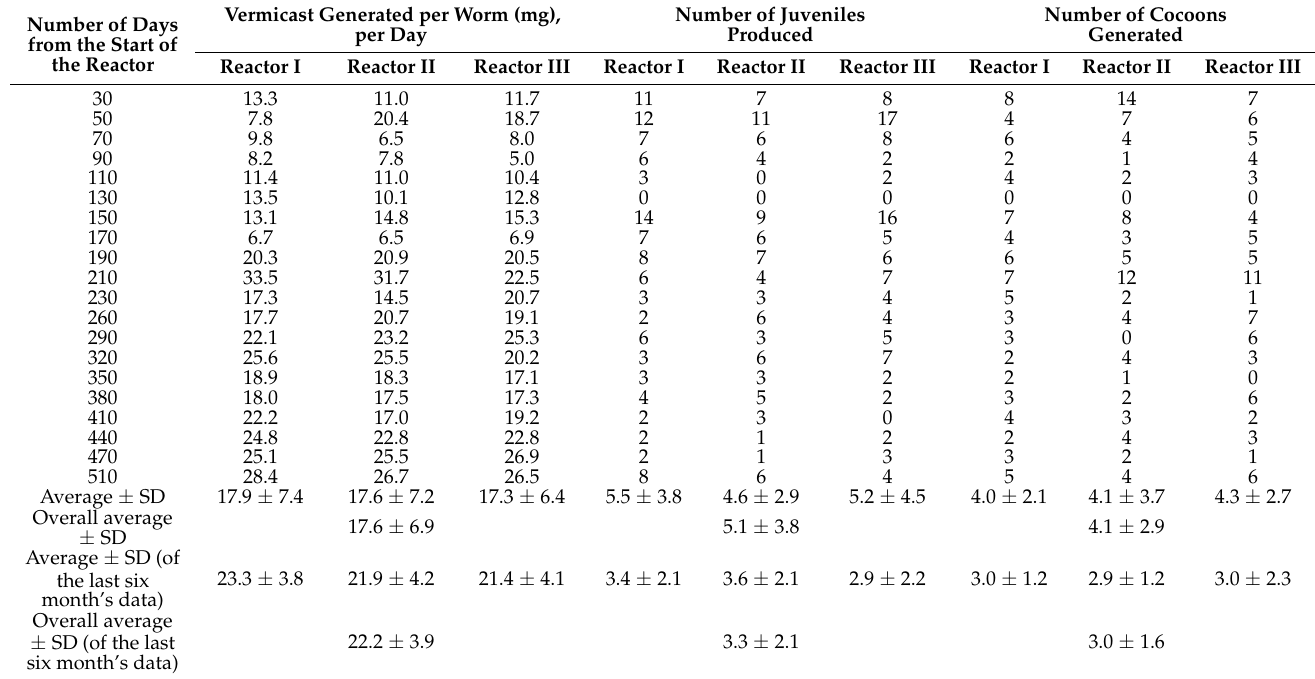
Table 8. Vermicomposting of parthenium with 80 adults of E. fetida per kg of feed in pulse-fed